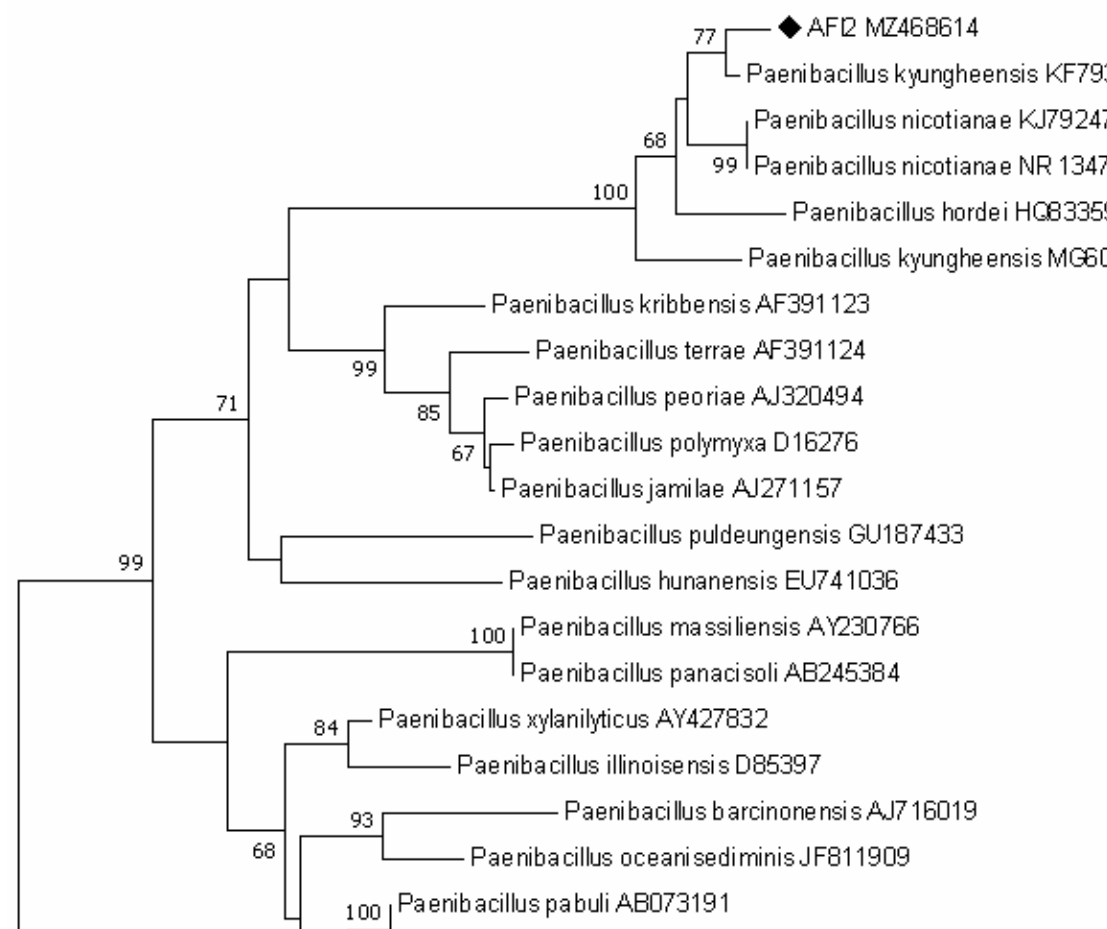
Figure 1. Neighbor-joining tree based on 16S rRNA gene sequence analysis showing the phylogenetic relationships of strain AFI1 and members of the genus Bacillus. Bootstrap values higher than 60% based on 1000 replications are shown at branching points. Thermobacillus xylanilyticus was used as an outgroup. Scale bar, 0.02 substitutions per nucleotide position. After a comparison of the nucleotide sequences of 16S rRNA genes, the greatest similarity was found with Paenibacillus nicotianae YIM-19 (98.84%), Paenibacillus kyungheensis DCY-88 (98.4%) and Paenibacillus hordei RH-N24 (98.03%). The phylogenetic tree (Figure 2) shows that AFI2 (MZ468614) clustered with Paenibacillus kyungheensis KF 793934 and with Paenibacillus nicotianae (68%).